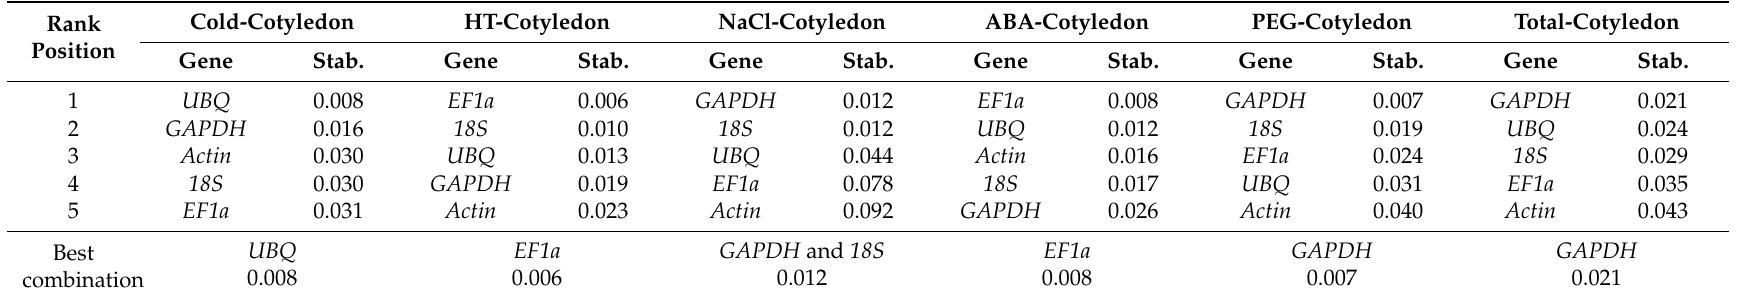
Table 2. Expression stability values and ranking of HKGs in Chinese fir cotyledon as calculated by the